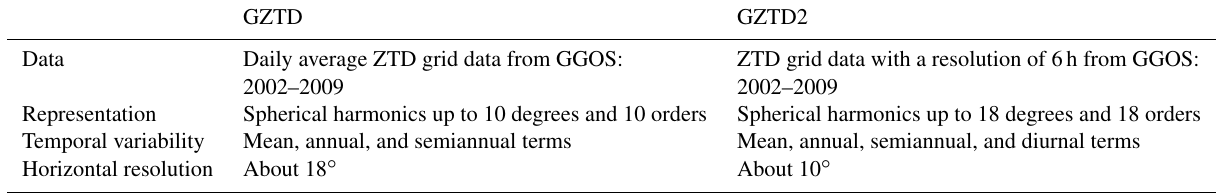
Table 1. Improvements of GZTD2 with respect to GZTD.